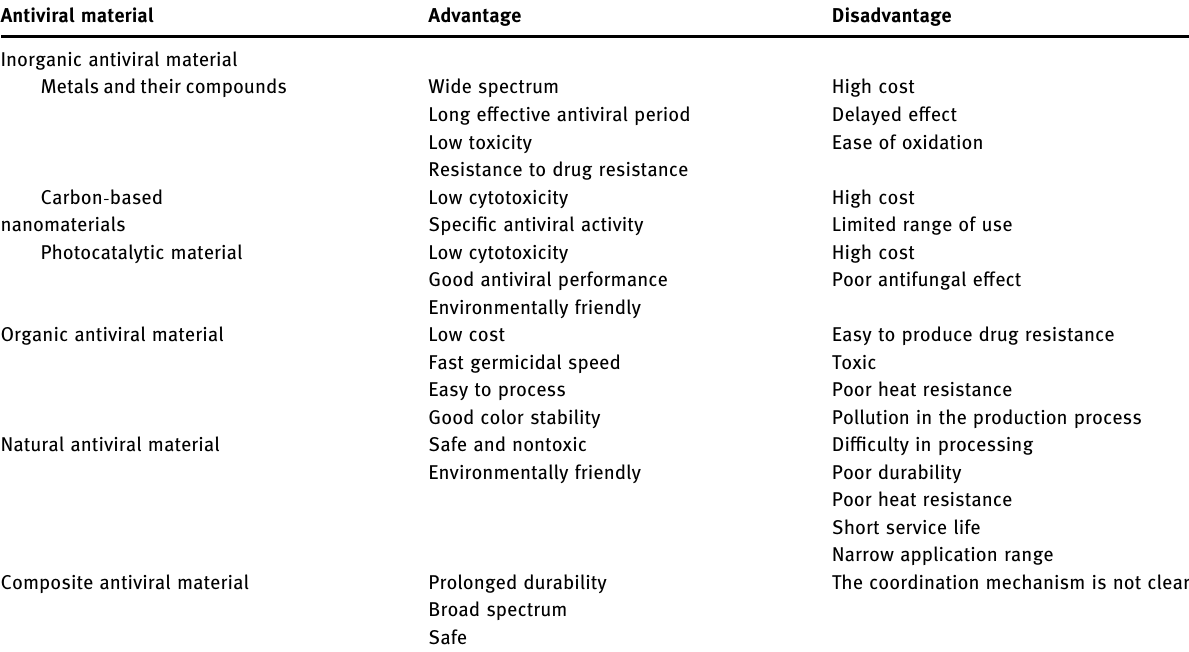
Table 2: Advantages and disadvantages of various antiviral materials Antiviral material Advantage